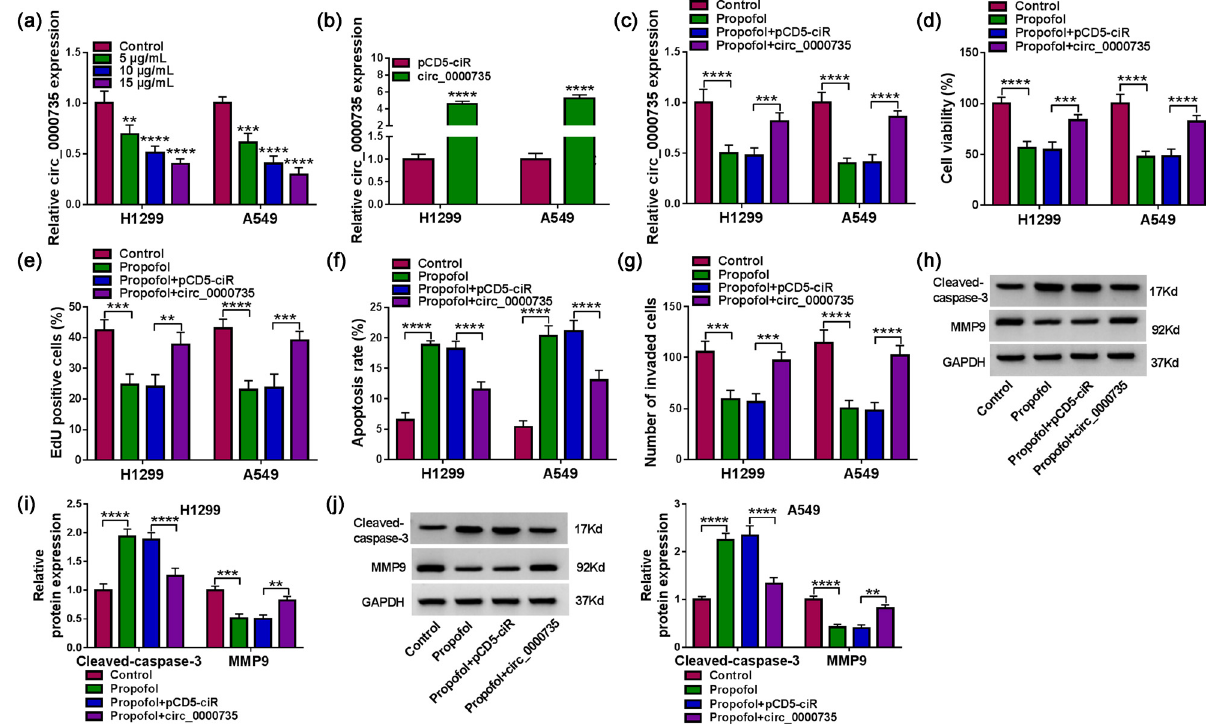
Figure 3: Propofol controlled cell proliferation, invasion, and apoptosis in NSCLC cells via regulating circ_0000735 expression. ( a ) Relative expression of circ_0000735 in NSCLC cells treated with 5, 10, and 15 μ g/mL propofol was detected using RT - qPCR ( n = 3 ) . ( b ) Relative expression of circ_0000735 in NSCLC cells transfected with circ_0000735 or pCD5 - ciR was evaluated using RT - qPCR ( n = 3 ) . ( c ) In fl uence of exogenous circ_0000735 on circ_0000735 expression in propofol - treated NSCLC cells was determined by RT - qPCR ( n = 3 ) . ( d – g ) Impacts of exogenous circ_0000735 on propofol - treated NSCLC cell viability, proliferation, apoptosis, and invasion were determined using MTT, EdU, fl ow cytometry, and transwell assays ( n = 3 ) . ( h – j ) E ff ects of exogenous circ_0000735 on protein levels of Cleaved - caspase3 and MMP9 in propofol - treated NSCLC cells were analyzed using western blotting ( n = 3 ) . ** P < 0.01, *** P < 0.001, and **** P <